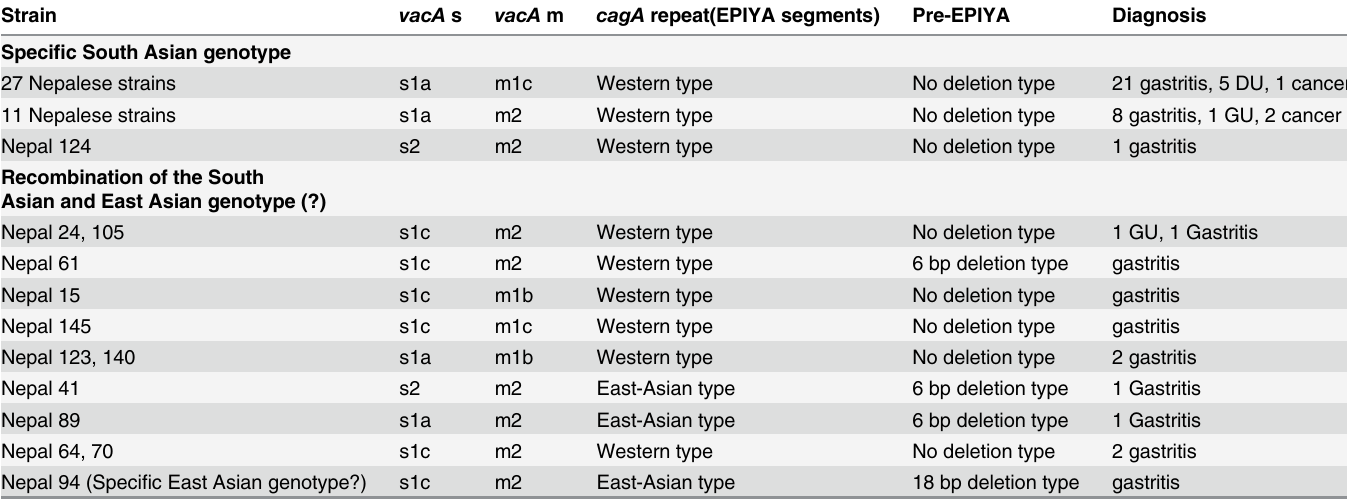
Table 4. Analysis vacA , cagA repeat and pre-EPIYA genotypes of Nepalese H . pylori strains.